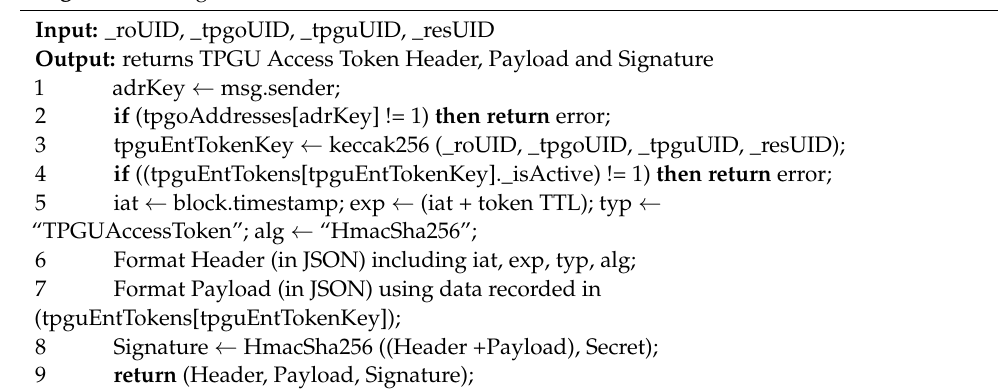
Algorithm 5: Algorithm to create a TPGU Access